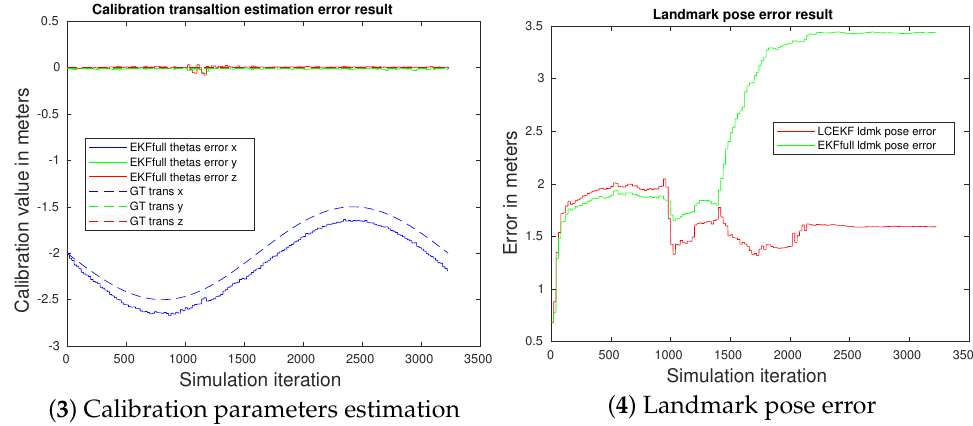
Figure 18. SLAM without the IMU and smooth sinusoidal noise. With overestimated random walk for K parameters, the estimation was not performed properly, making the EKFfull diverge. Note that there was no impact on the LCEKF as the K calibration parameters were not